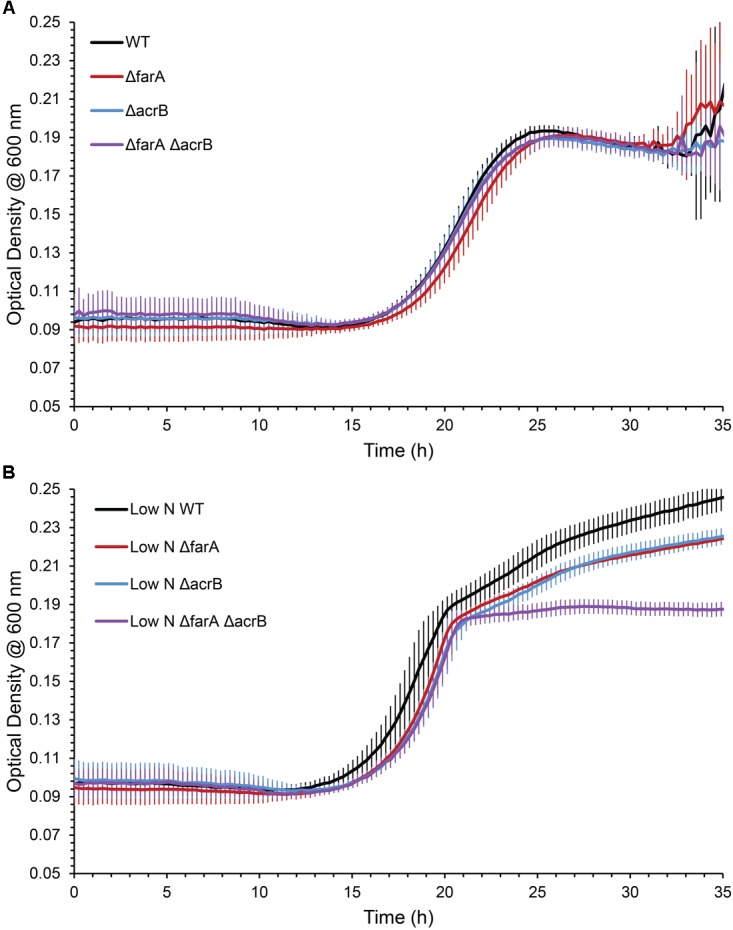
Average (n = 3) OD600nm of WT, ΔfarA, ΔacrB, and ΔfarA ΔacrB strains of CP1 under (A) regular growth conditions (ASW media, 26 mM succinate) and (B) low nitrogen growth conditions (ASW, 26 mM succinate, 0.1 g/L NH4Cl) for 35 h.